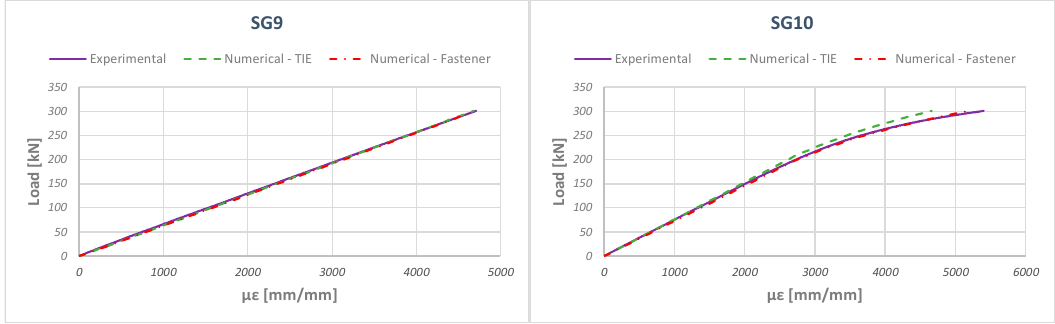
Figure 16. Numerical–experimental comparisons for SG-9 and SG-10: numerical TIE and Fasteners models.